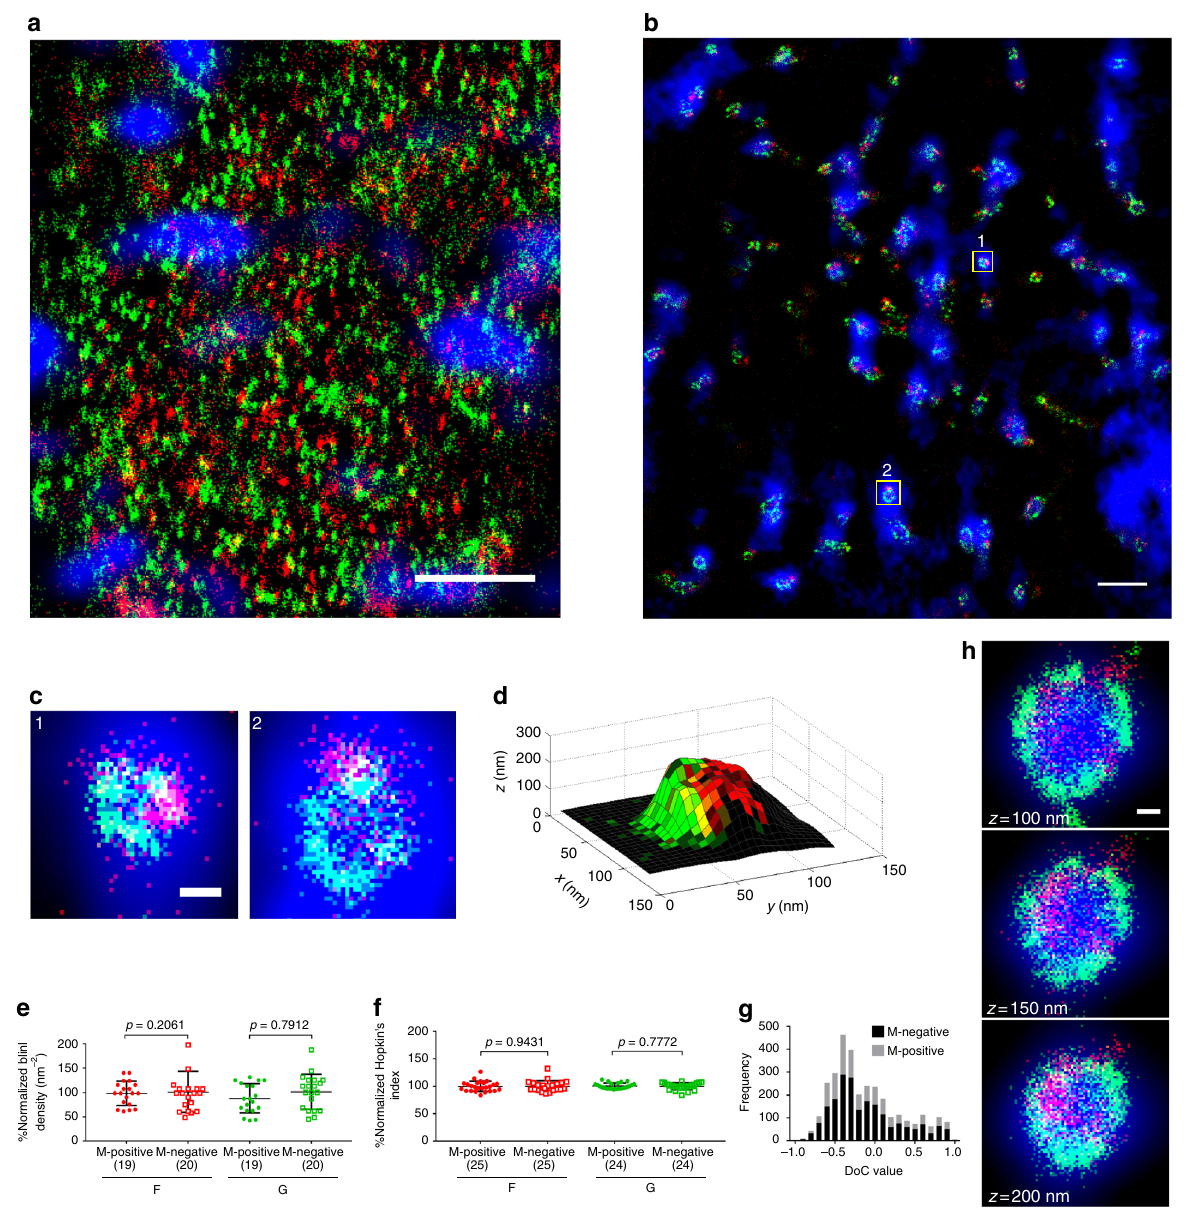
Fig. 3 Presence of M does not affect the arrangement of the envelope glycoproteins ’ clusters on the membrane. PK13 cells were co-transfected with NiV- M, -F, and -G and fi xed at 24 h post transfection. Without permeabilization, F was immunostained using a mouse anti-FLAG primary antibody and an anti- mouse Cy3B secondary antibody, and G an anti-HA primary antibody and an anti-rabbit Alexa Fluor 647 secondary antibody. a , b x – y cross section (100 nm thick in z ) of a representative cell shows the superimposition of a wide fi eld image for M (blue) and the corresponding SMLM images of F (red) and G (green) on the cell body ( a ) and membrane protrusions ( b ). Scale bar: 1 μ m. c x – y cross section (100 nm thick in z ) of the M-positive sites ( c1 , 2 ) boxed in b . Scale bar: 0.1 μ m. d 3D surface reconstruction of the dome-like structure in c1 , with F (red) and G (green) localization densities projected on the surface. A higher brightness indicates a higher localization density. e Comparison of the localization densities of F (red) or G (green) on the M- positive and M-negative regions at the dorsal surface of the cell. f Comparison of the Hopkins ’ indices of F (red) and G (green) in the M-positive and M- negative regions at the plasma membrane. All data in e and f were normalized to the mean of the M-negative regions of the same cell. Lines represent the mean value and SD. The sample size is indicated in the parentheses. The p values were determined by two-tailed, unpaired t -test with Welch correction. g The distribution of the DoC values between F and G molecules in the M-negative and M-positive regions. h VLPs produced in PK13 cells expressing M, F, and G were adhered to fi bronectin-coated coverslips, fi xed, and stained for NiV-F and G via tags described above. The z -stacks of the x – y cross section of a VLP show the super-imposition of a wide fi eld image of M (blue) and the corresponding SMLM images of F (red) and G (green). Scale bar: 0.1 μ Methods contamination by using a mycoplasma detection PCR kit (Applied Biological Cell culture . PK13 (pig kidney fi broblast, American Type Culture Collection; Materials). ATCC, CRL6489) 13,34 and HeLa cells (ATCC, CCL-2) were grown at 37°C and 5% CO 2 in Dulbecco ’ s modi fi ed Eagle ’ s medium supplemented with 10% fetal bovine serum, 50IU penicillin per ml, 50 μ g streptomycin per ml, and 2 mM glutamine Expression plasmids and transfection . The codon-optimized NiV-G with a C- (Life Technologies). Cell cultures were monitored routinely for mycoplasma terminal HA tag was constructed as previously described (genbank accession no.